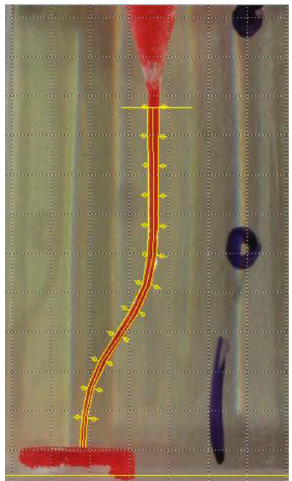
Figure 2: The pattern used to measure transportation at each cross-section. From the apical part of simulated canal: the first, the second, and the third cross sections were assumed as the apical third; the forth, the fifth, the sixth, and the seventh cross sections were assumed as the middle third; the eighth, the ninth, and the tenth were assumed as the coronal